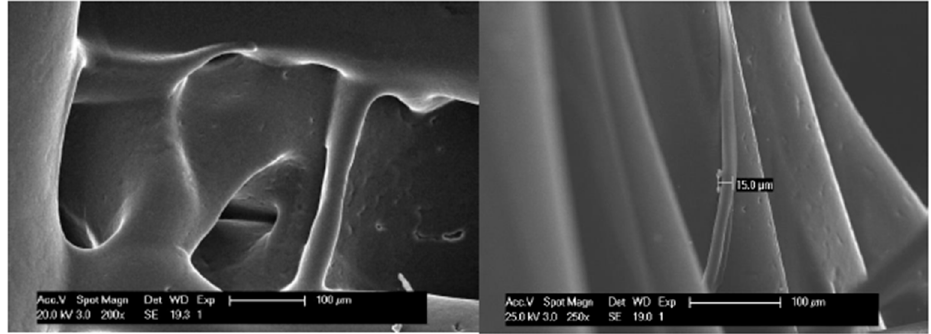
Figure 4. Micrograph of macro and micro pores and microfibres created randomly for a slow cooling down (not forced air flow) of the PCL (30% n-ALT). Scale bars: 100 µm.